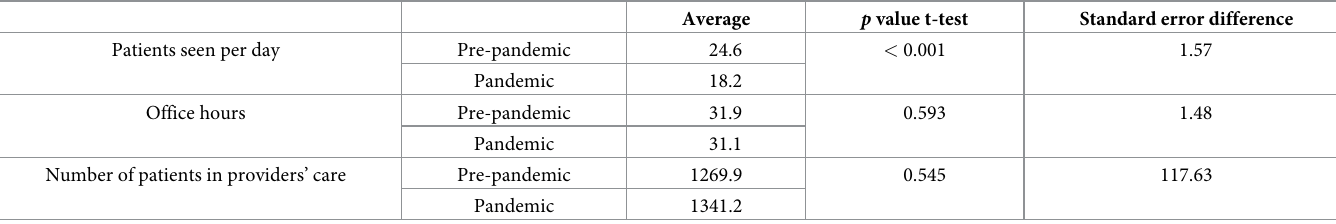
Table 4. Timely access to primary care indicators pre-pandemic and during the COVID-19 pandemic ( n = 114).